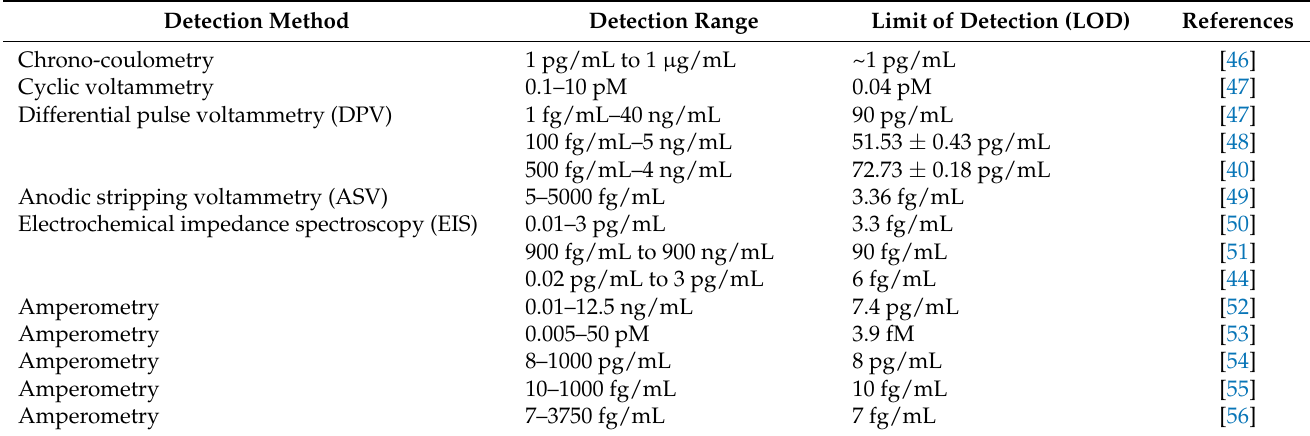
Table 2. Various detection methods for IL-8